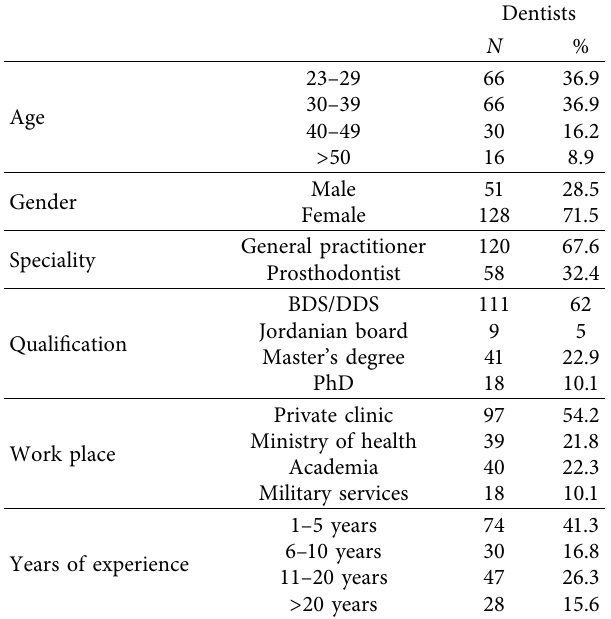
Table 2: Frequencies and percentages (%) of GPs and PDs’ answers to questions measuring awareness and knowledge of tooth